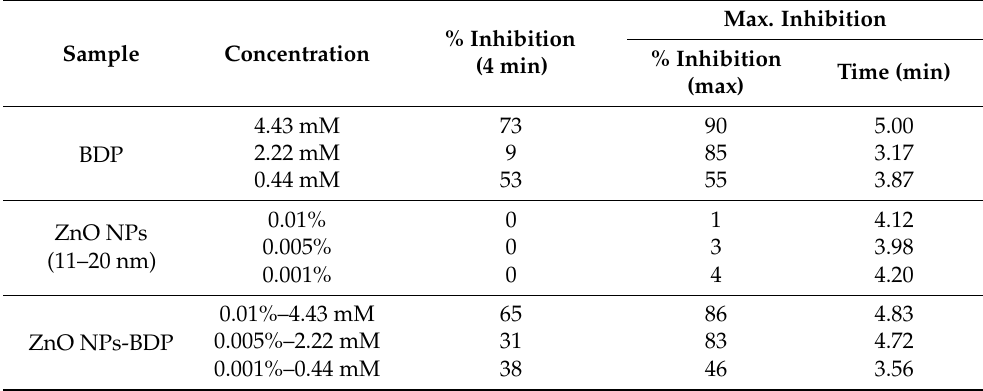
Table 3. The inhibition (%) of platelet aggregation under the action of various concentrations of substances.